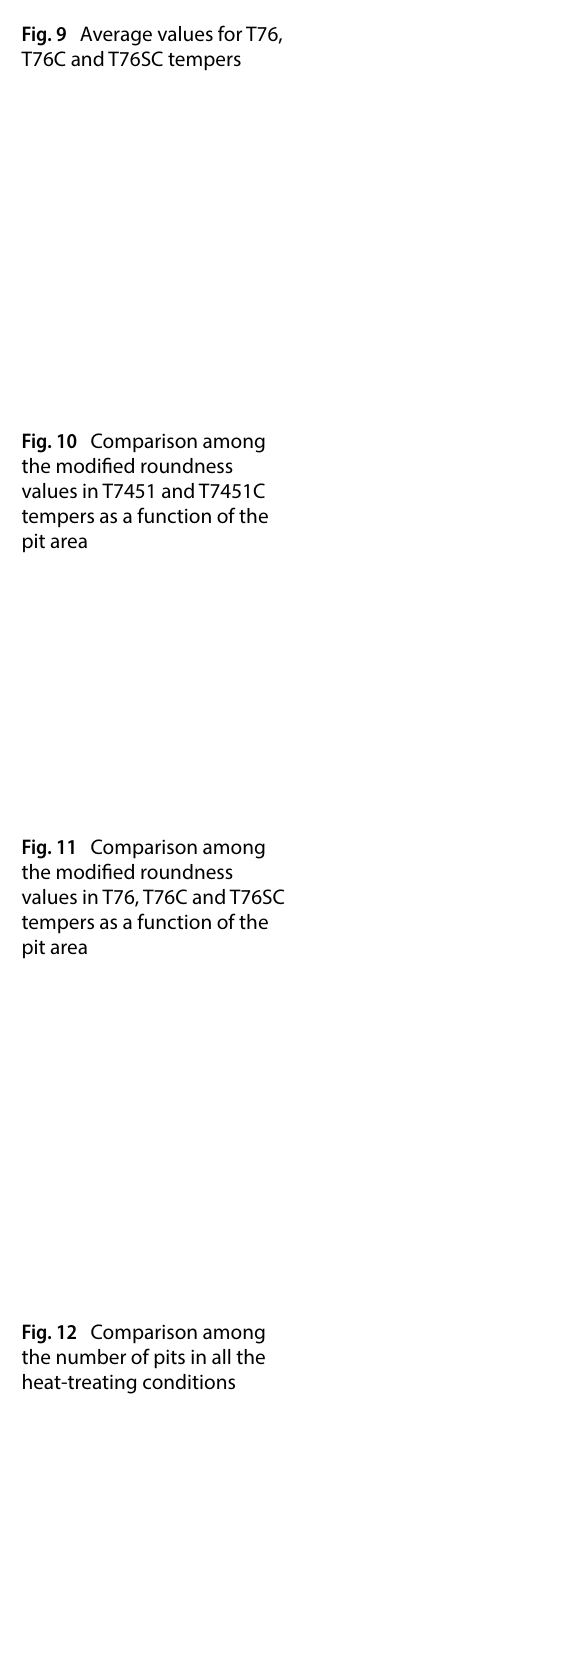
Fig. 9 Average values for T76, T76C and T76SC tempers